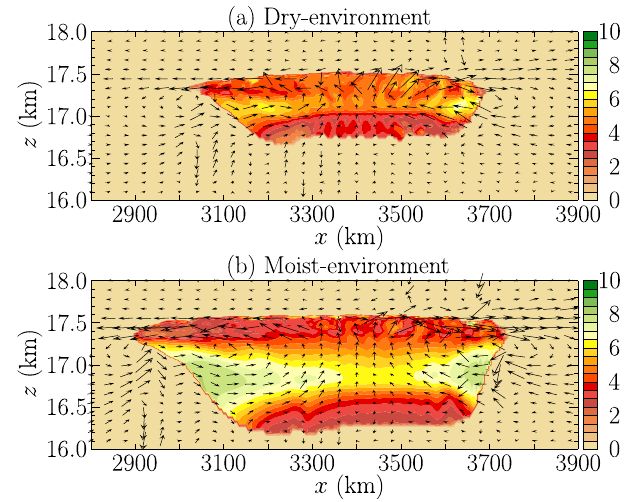
Figure 2. Mean crystal radius (µm) at t = 3 . 5d in the all-phys sim- ulations in (a) the dry scenario and (b) the moist scenario. Vectors show the radiatively induced